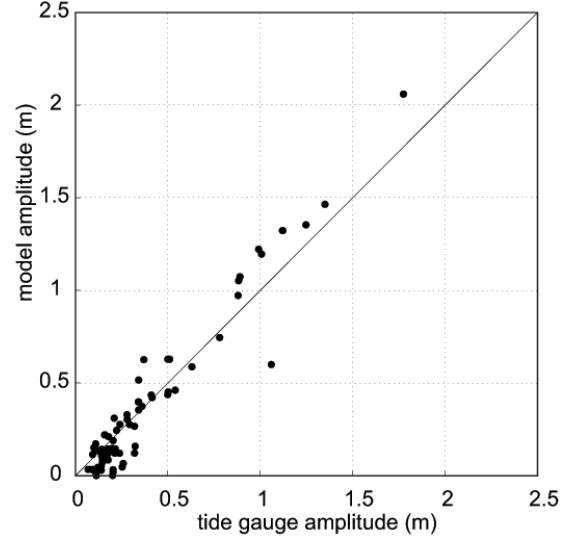
Fig. 4. Comparison of M2 model amplitude with tide gauge ob- servations (Gjevik and Straume, 1989; IHO, 1994; Kowalik and Proshutinsky, 1994,